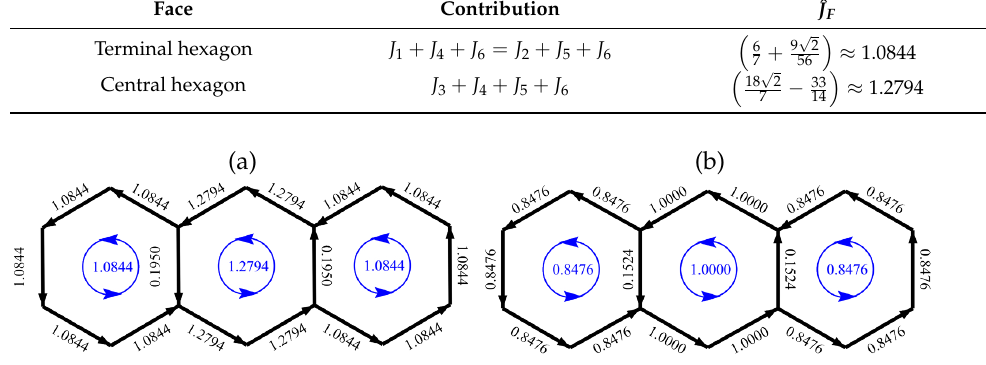
Figure 1. Hückel London ring-current maps for anthracene: ( a ) raw and ( b ) scaled currents.